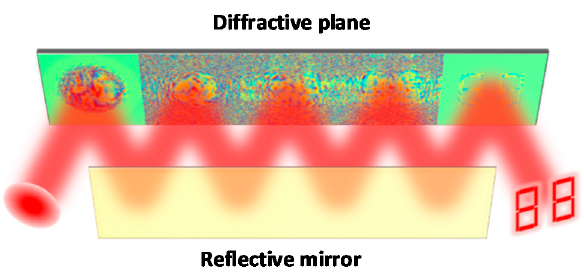
Figure 2. The principle of the MPLC matrix core. The MPLC matrix core is composed of a series of diffractive planes encoded with amplitude and phase information. By configuring the parameters of these diffractive planes, the light beam irradiated on the plane surface can be modulated to change amplitude and phase.